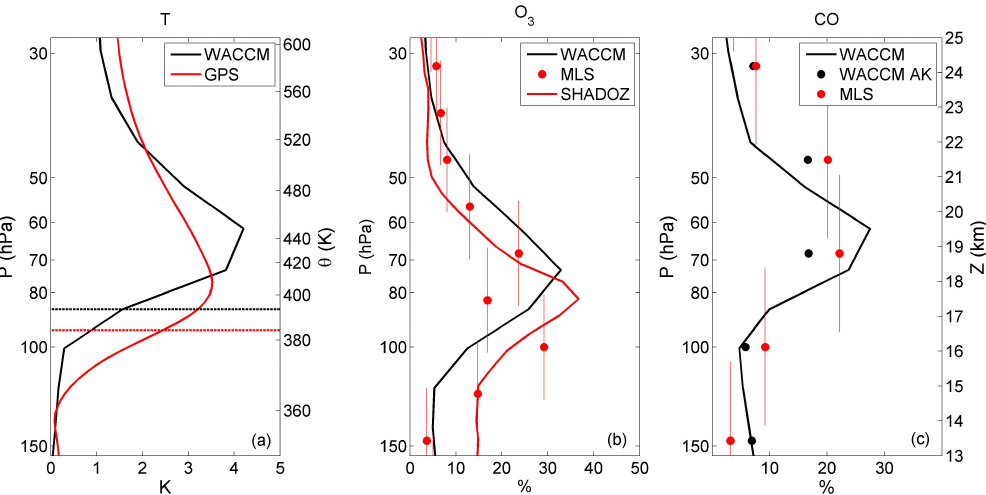
Fig. 4. As in Fig. 1 but for the vertical structure of annual cycle amplitude in temperature (a) , ozone (b) and CO (c) in the tropics. The amplitude for the tracers is shown relative to the annual mean concentration.